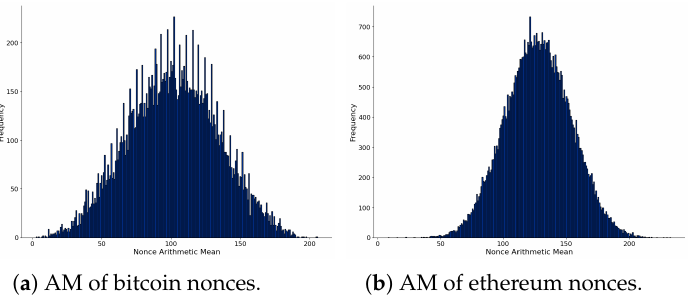
Figure 3. Comparison of nonces of bitcoin ( left ) and ethereum ( right ) from the first chunk of parsed blockchain data. AM is the Arithmetic Mean of each